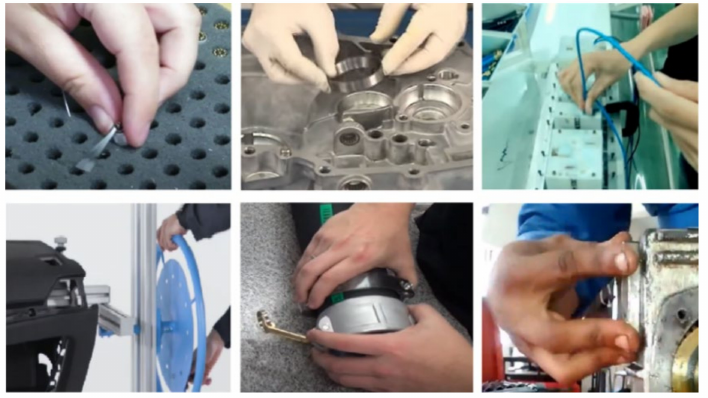
Figure 13. Image frames from Assembly Gesture Video Dataset.